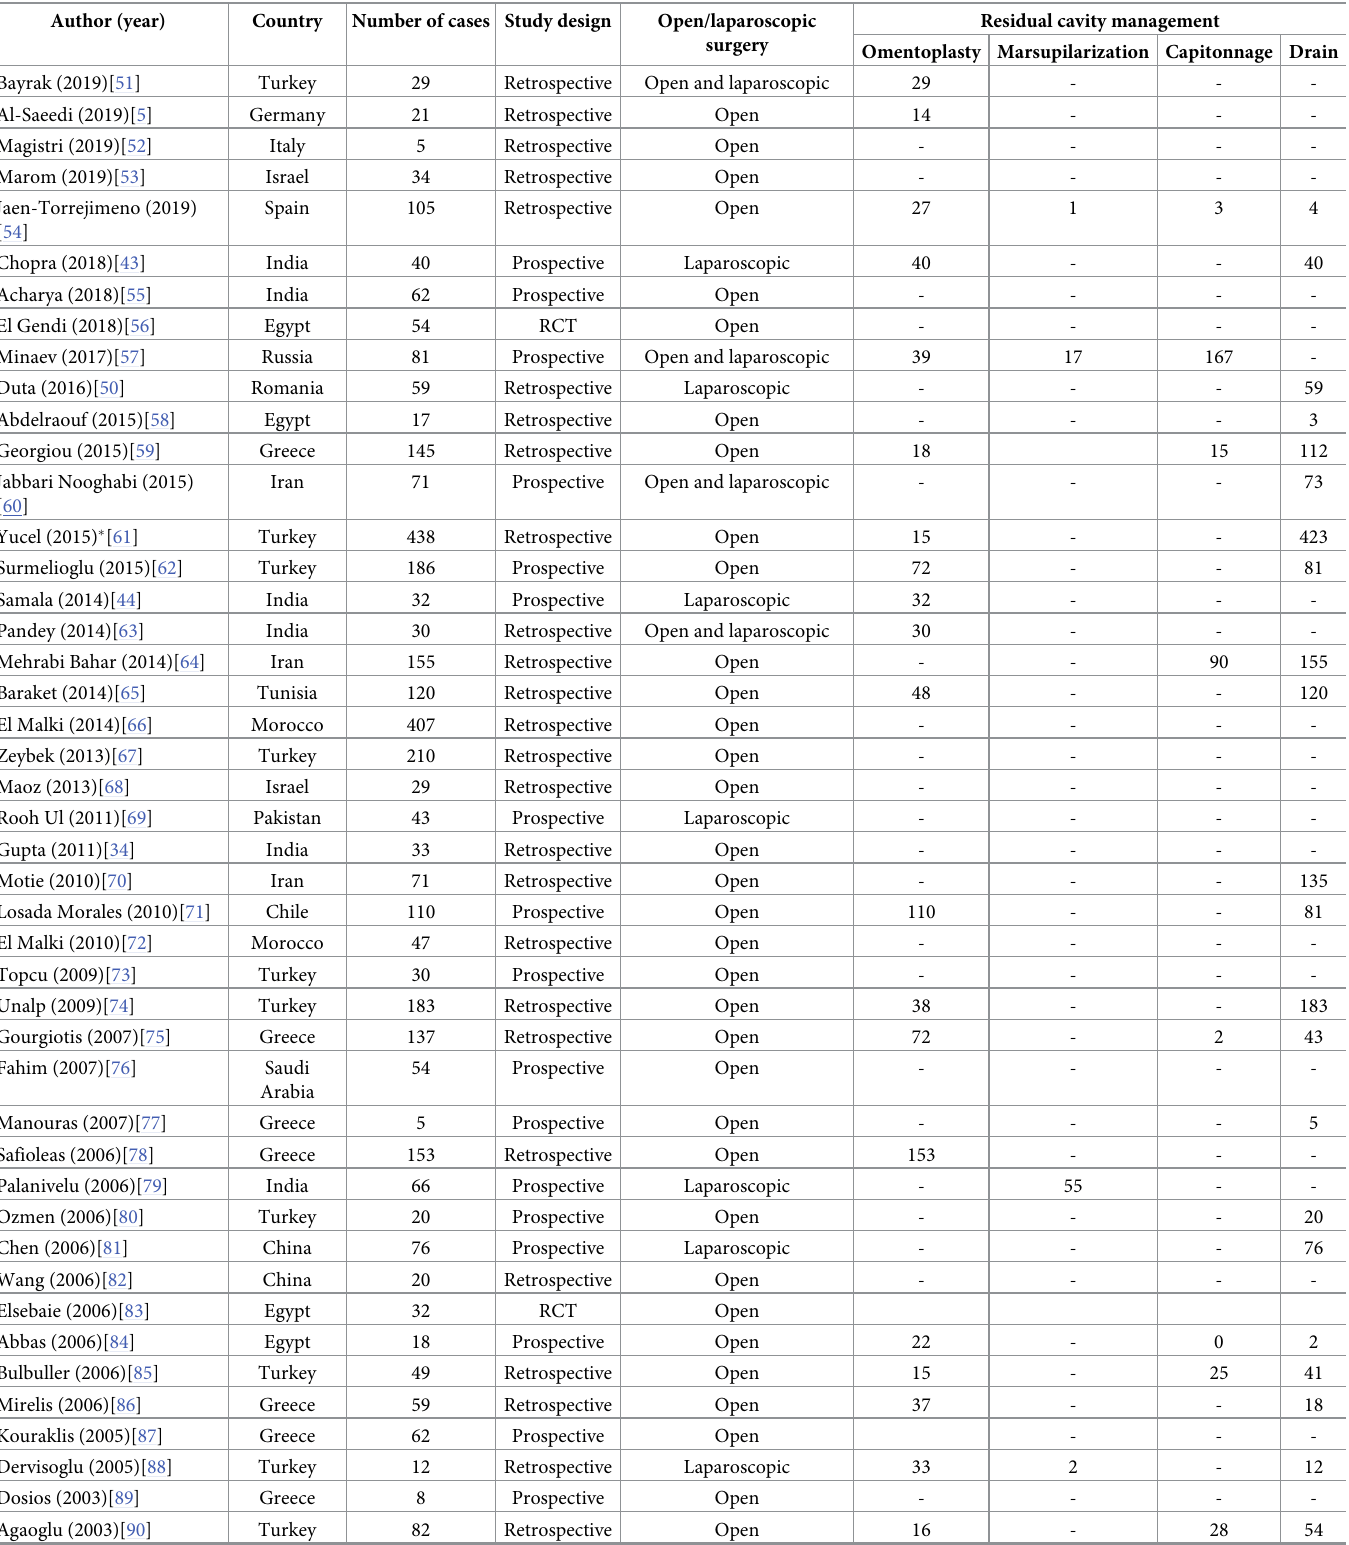
Table 1. Study design, sample size, surgical technique, and residual cavity management. Author